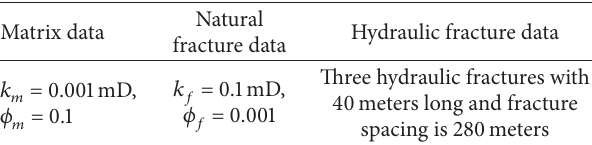
Table 3: DPDP data (if not specified additionally).